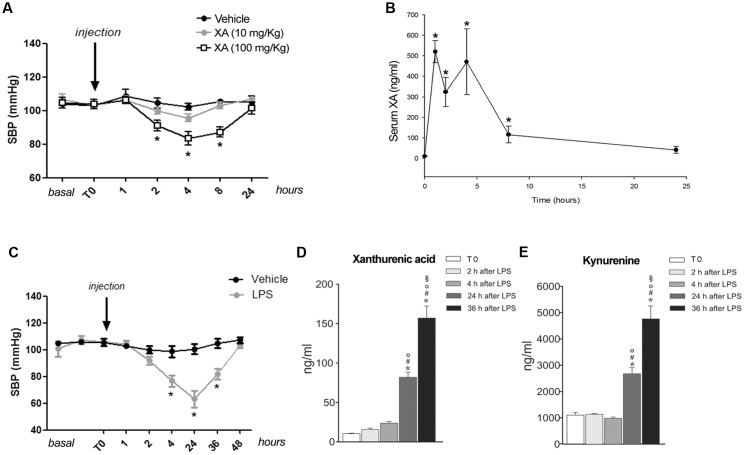
Xanthurenic acid (XA) lowers blood pressure in mice and its serum levels are increased after injection of LPS. (A) Systolic blood pressure (SBP) in C57BL/6 mice treated with vehicle or increasing doses of XA (10, 100 mg/kg). Values are means ± S.E.M. of 10–13 determinations. ∗p < 0.05; (One-way ANOVA + Bonferroni’s Multiple Comparison Test). (B) Serum levels of XA after the i.p. injection of XA (100 mg/kg); ∗p < 0.05 vs. time of XA injection (One-Way ANOVA + Fisher’s LSD). (C) SBP in mice treated with vehicle or LPS (1 mg/kg). Values are means ± S.E.M. of eight determinations. ∗p < 0.05; (Two-way ANOVA + Bonferroni’s Multiple Comparison Test). (D,E) Serum levels of XA and L-kynurenine at different time points after LPS injection. Blood samples were collected at different time points after LPS injection in anesthetized mice. Time 0 = 2 min prior LPS injection. Values are means ± S.E.M. of 3–4 determinations. ∗p < 0.05 vs. time of LPS injection; #p < 0.05 vs. 2 h after LPS; °p < 0.05 vs. 4 h after LPS; x
p < 0.05 vs. 24 after LPS (One-way ANOVA + Fisher’s LSD).